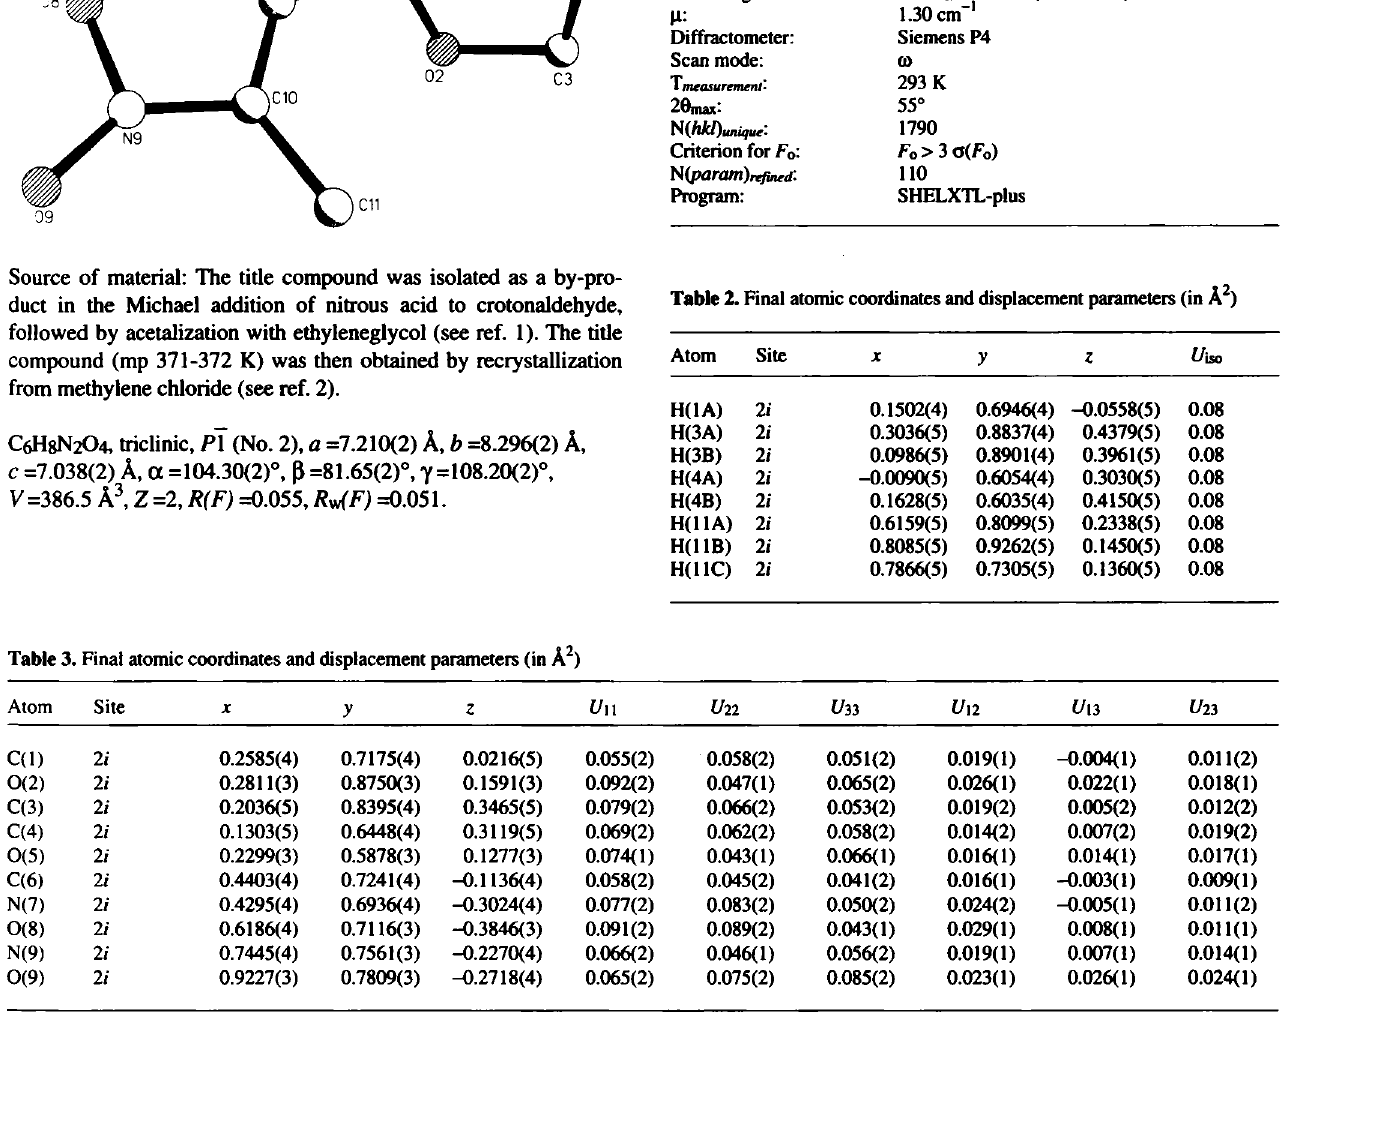
Table 1. Parameters used for the X-ray data collection Crystal: